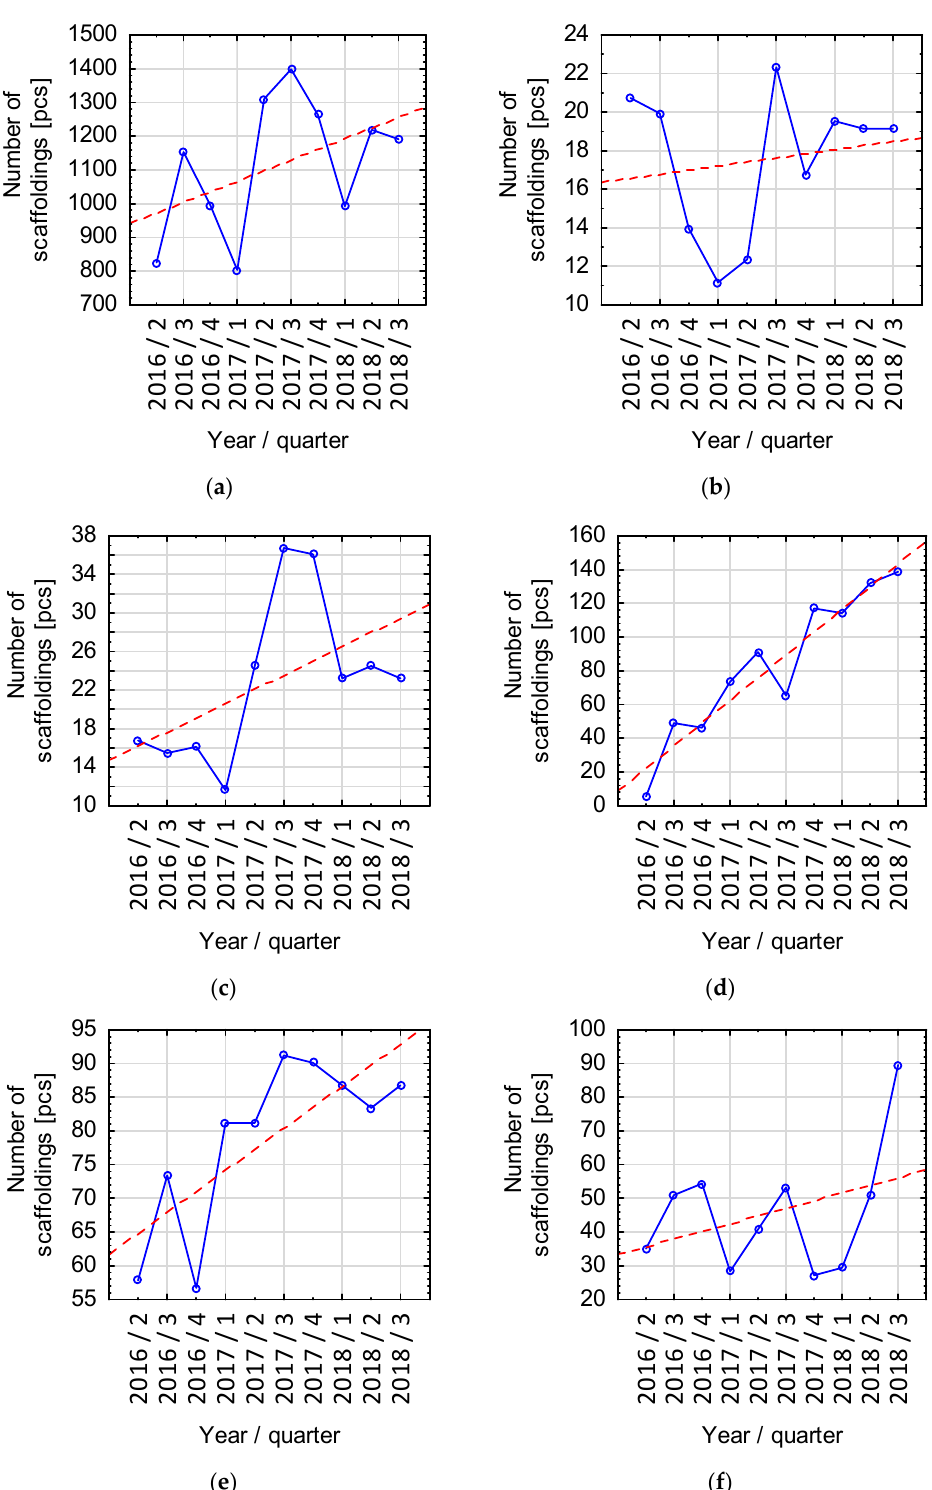
Figure 4. The designated number of scaffoldings in the analysed towns of the Dolnoslaskie region in the period from 2016 to 2018: Wroclaw—the capital of the region ( a ); Jawor ( b ); Jelcz-Laskowice ( c ); Siechnice ( d ); Sroda Slaska ( e ); Swidnica ( f